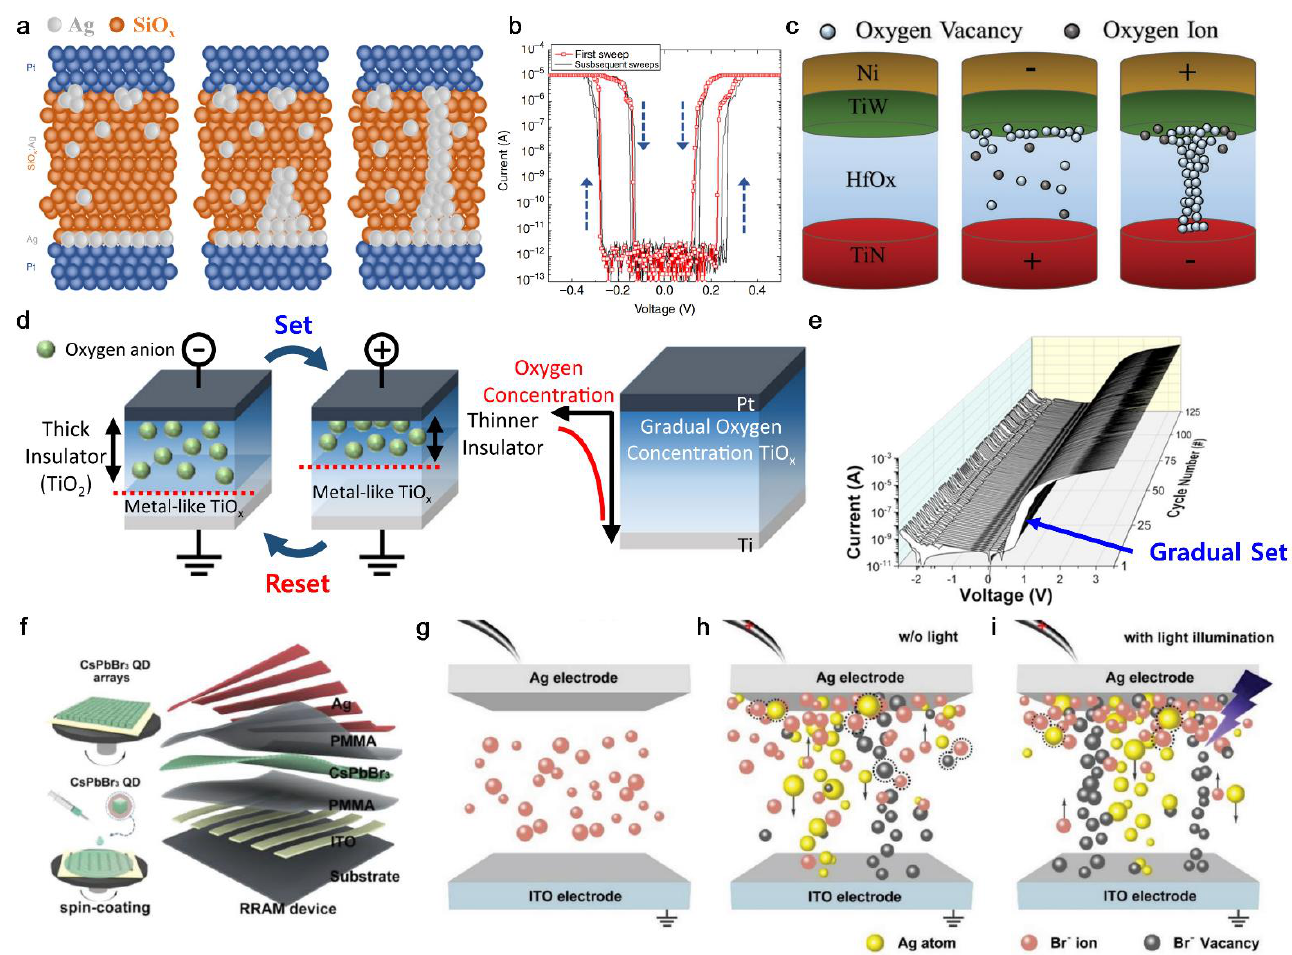
Figure 2. Representative mechanisms of ion-mediated memristors. ( a ) Schematic of Ag cation filament formation through a silicon oxide host layer. Following formation, the device reversibly changes its resistance state, as mediated by filament formation/rupture. ( b ) I – V curve of an Ag filament memristor showing unipolar property; set and reset occur in the same voltage sweep direction; adapted with permission from ref. [82], copyright 2018 Springer Nature. ( c ) Schematic of memristor based on oxygen vacancy filament formation; adapted with permission from ref. [84], copyright 2022 Wiley-VCH Verlag GmbH & Co. ( d ) Schematic of valence change resulting from the migration of oxygen ions and consequent changes in total resistance. The thickness of the insulating TiO x layer increases/decreases via oxygen ion migration. ( e ) Voltage sweep cycles of a TiO x memristor with stable gradual set (blue arrow); adapted with permission from ref. [85], copyright 2022 Springer Nature. ( f ) Schematic of a CsPbBr 3 quantum-dot-based resistive random-access memory (RRAM) device. ( g – i ) Illustration of resistance switching from ( g ) the initial state; set process occurring under ( h ) applied voltage only, and ( i ) under ultraviolet (UV) illumination; adapted with permission from ref. [86], copyright 2018 Wiley-VCH Verlag GmbH & Co.